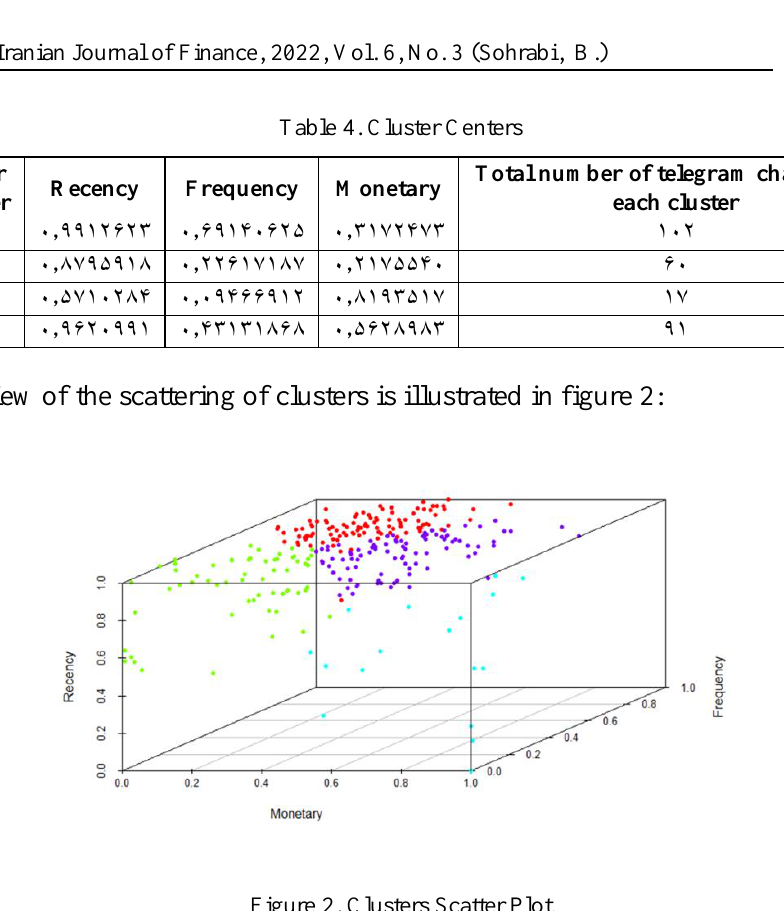
Figure 2. Clusters Scatter